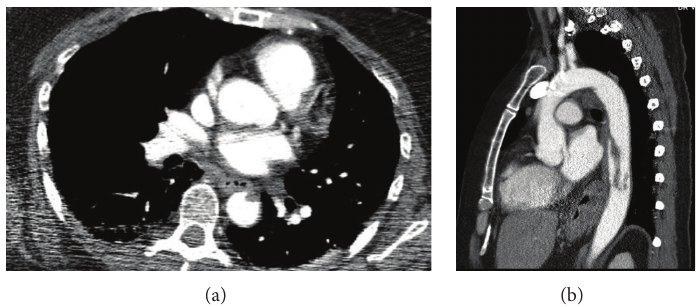
Figure 1: Axial and sagittal images of a computed tomography angiogram demonstrating a serpiginous filling defect in the descending thoracic aorta.